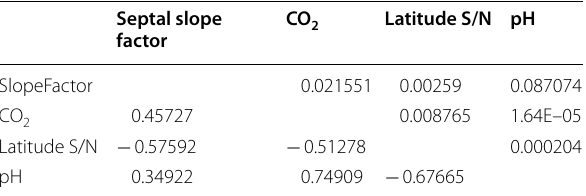
Table 8 Linear correlation matrix of the septal slope factor and the main abiotic environmental factors Septal slope